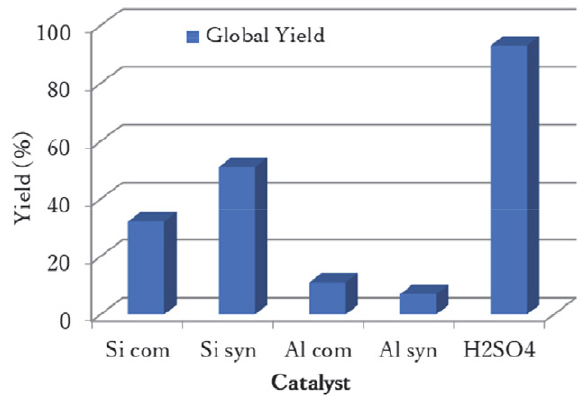
Figure 2. Evaluation of the overall yield in the presence of H 2 SO 4 (4% wt.) and catalysts based on silica gel and alumina (1.3%